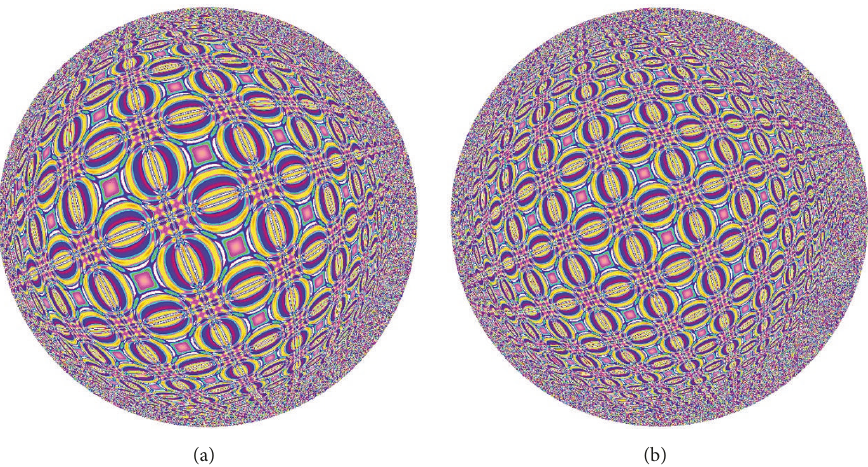
Figure 3: Two spherical wallpaper patterns with the 𝑝4𝑚 symmetry, in which the projection plane was set as 𝑍 = −2𝜋 (a) and 𝑍 = −4𝜋 (b).